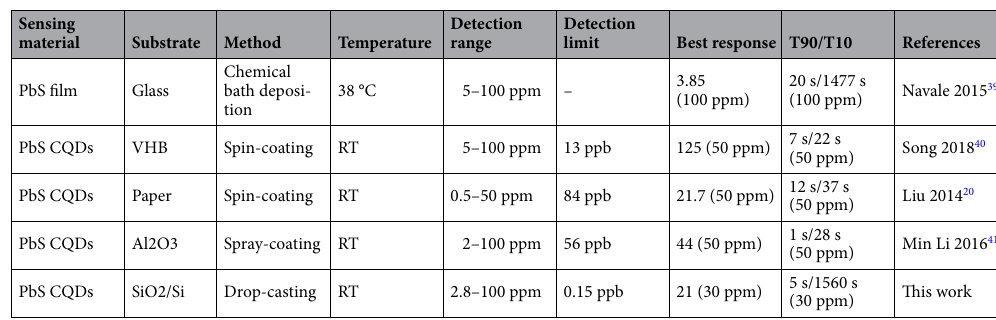
Table 1. Recent room temperature NO 2 sensors using PbS as sensing